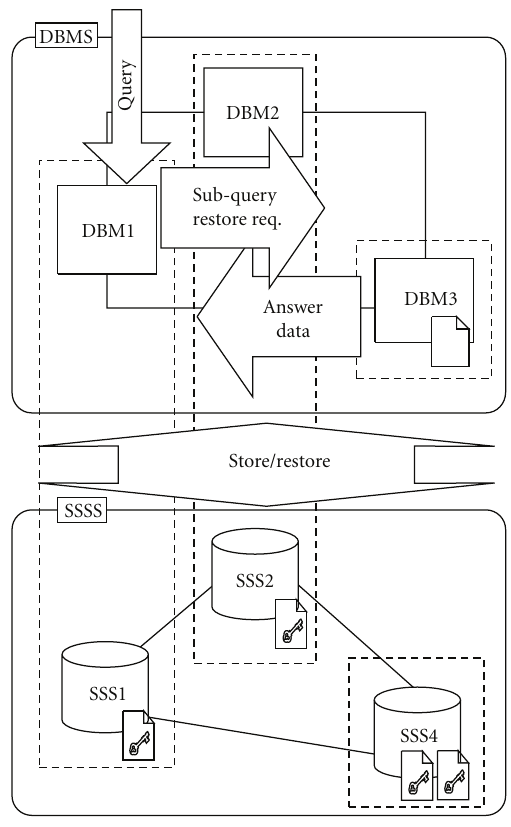
Figure 1: Secret Sharing Distributed